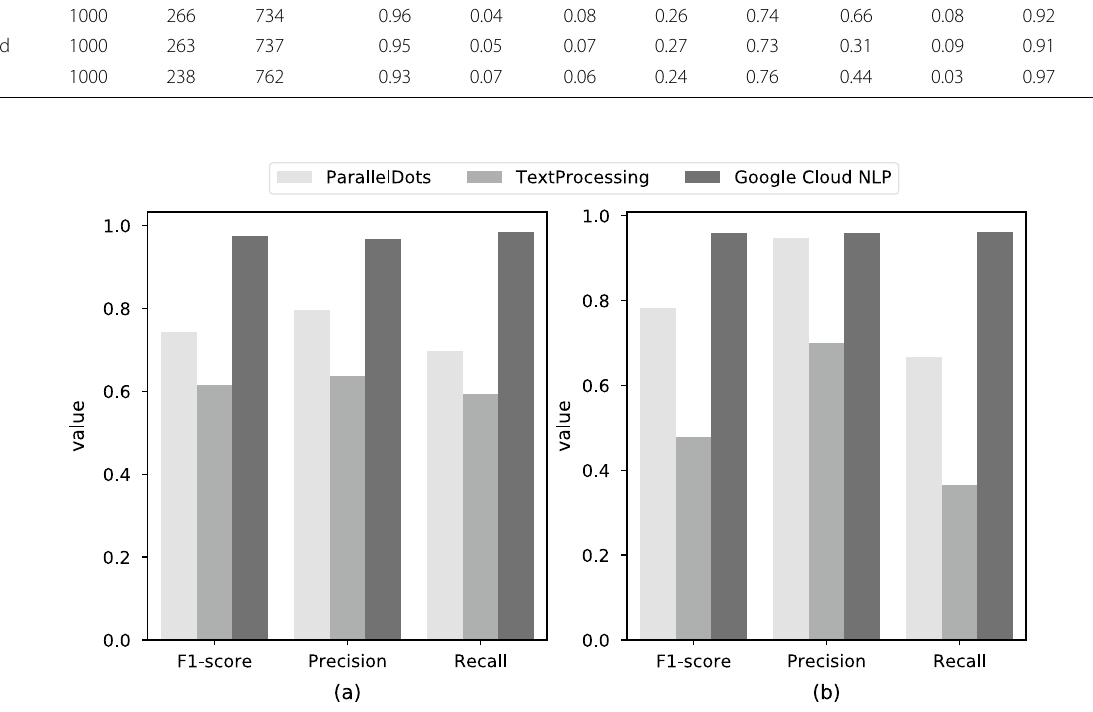
Fig. 8 The performance of different sentiment analysis tools for a CSs and b